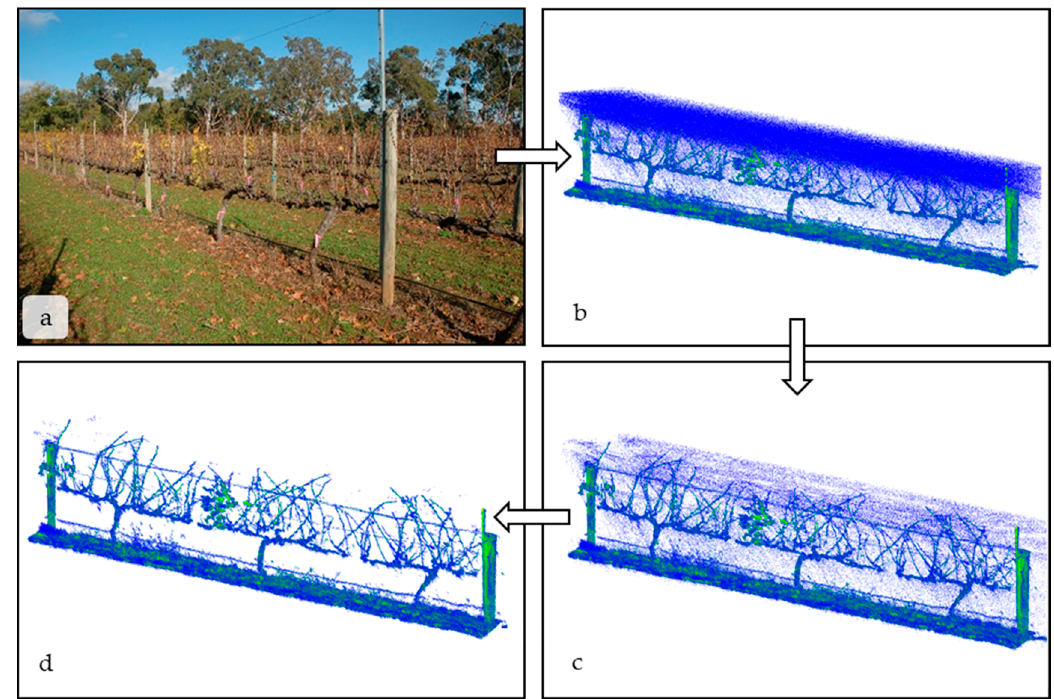
Figure 2. Following the arrows clockwise from panel ( a – d ), this figure depicts the workflow used to process scans before computational analysis. ( a ) depicts a single panel of vines in May 2015 after nearly complete senescence; ( b ) shows the raw LiDAR scan of the panel before any erroneous points are removed using an intensity filter. Less reflective, low intensity returns are blue (e.g., green grass) and more reflective, high intensity points (e.g., senesced leaves, leaf litter) are green and yellow; ( c ) shows the LiDAR scan after removal of low intensity points; ( d ) is the LiDAR scan after a nearest neighbor filter is applied to remove any outliers. All scans are visualized and processed using the open source program CloudCompare.